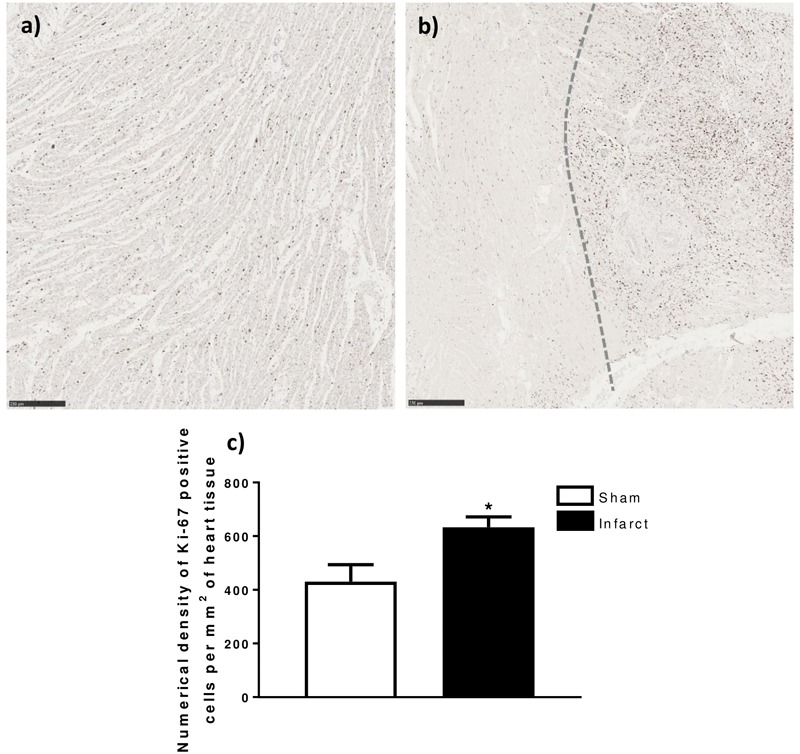
Ki-67 quantification in fetal heart tissue after infarction. (a) Representative Ki-67 stained LV heart tissue (5× Magnification) 105 days sham Fetus. (b) Representative Ki-67 stained infarct (left side) and border zone (right side) heart tissue (5× Magnificaion) 105 days MI Fetus. (c) Numerical density of Ki-67 positive DAB Stained cells per mm2 of whole heart tissue sections ± standard deviation. ∗represents significant difference as result of treatment (P < 0.05). Analysis was performed using a Student’s t-test (Sham n = 5, Infarct n = 5). Scale bars = 250 μm.